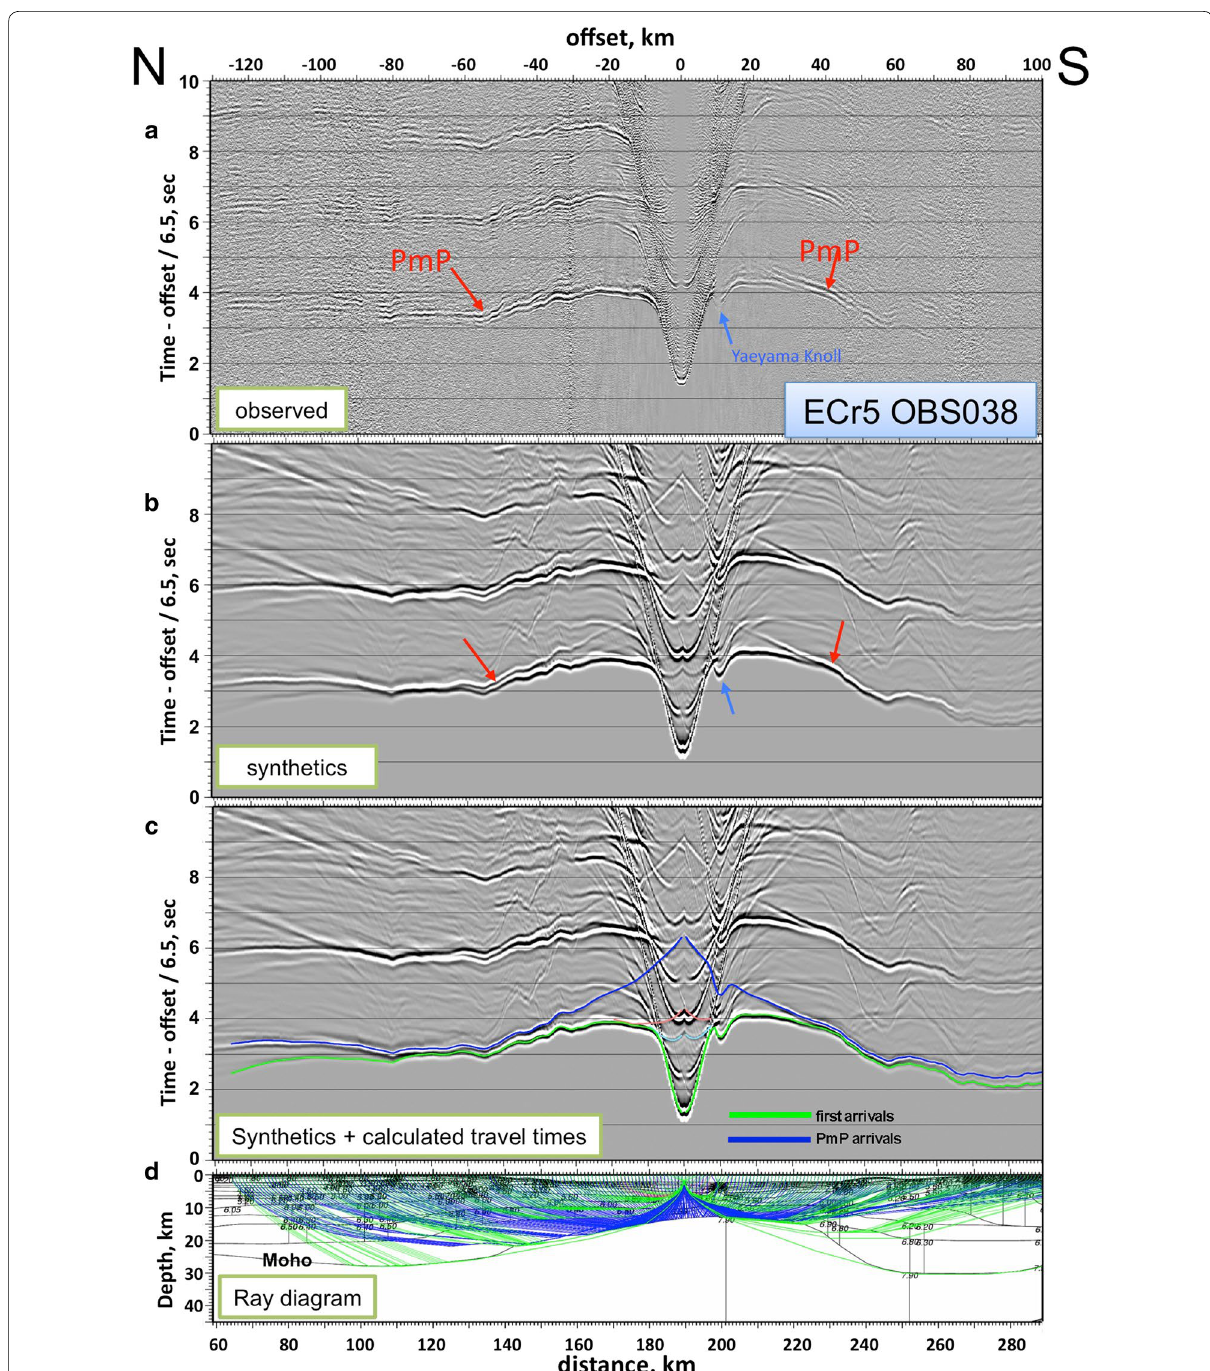
Fig. 10 Example of forward modeling for ECr5. a Observed record section of OBS038. Red arrows and blue arrows indicate PmP signals and refraction waves propagating through the Yaeyama Knoll, respectively. The position of the OBS038 is indicated by a red inverse triangle in Fig. 2. b Synthetic seismograms. c Calculated travel times on the synthetic seismograms. d Ray diagram. The ray paths are generated at equal